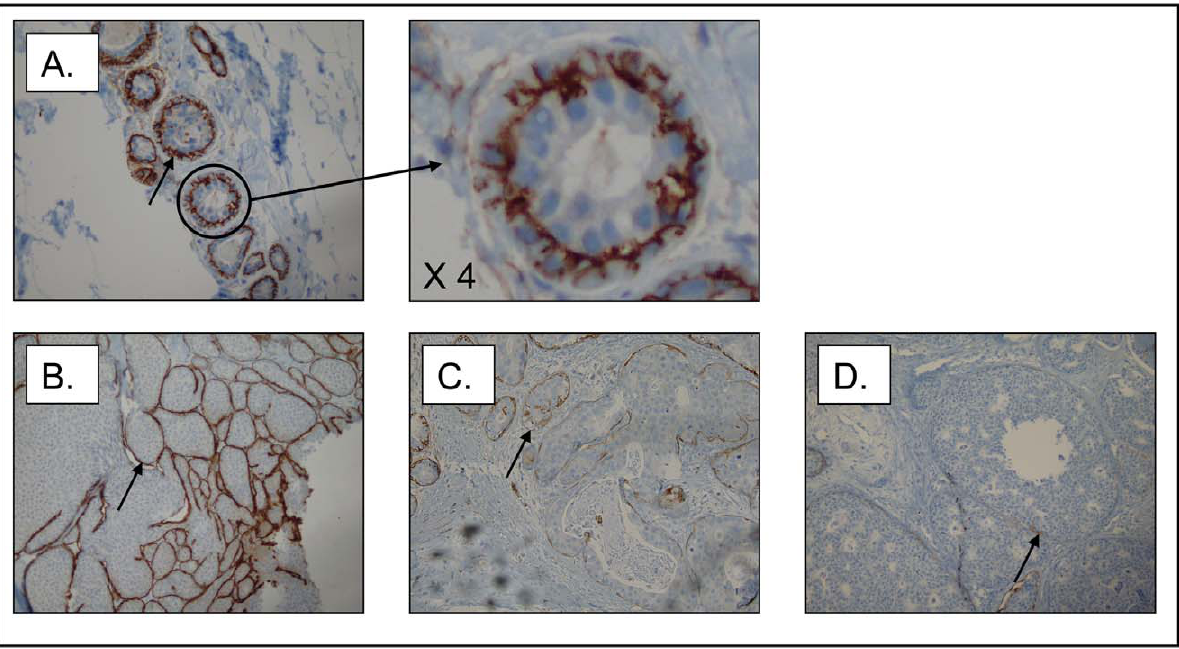
Figure 1. CD10 immunostaining of the myoepithelial cell (MECs) layer (original magnification 6 200). (A) intense staining (3) and a circumferential membrane expression (3) observed on normal breast (score=6); (B) intense staining (3) and a circumferential membrane expression (3) observed on DCIS (score=6); (C) intermediate staining (2) and partial membrane expression (2) observed on DCIS (score=4); (D) weak staining (1) and focal membrane expression (1) observed on DCIS (score=2).